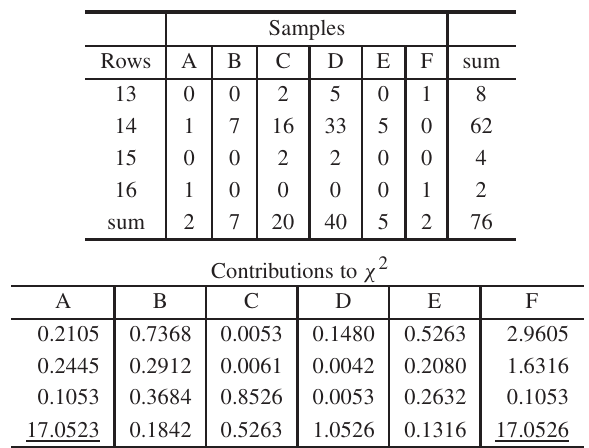
G. carvalhoi , geographical differentiation, tubercle